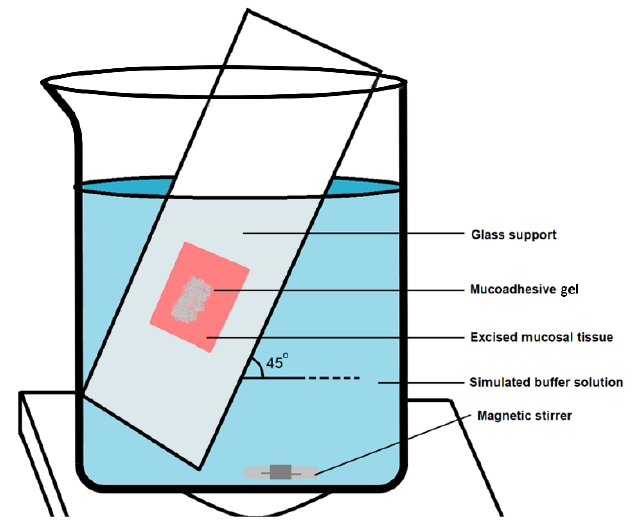
Figure 2. Experimental set up for the determination of ex vivo mucoadhesive time of buccal gel formulations.